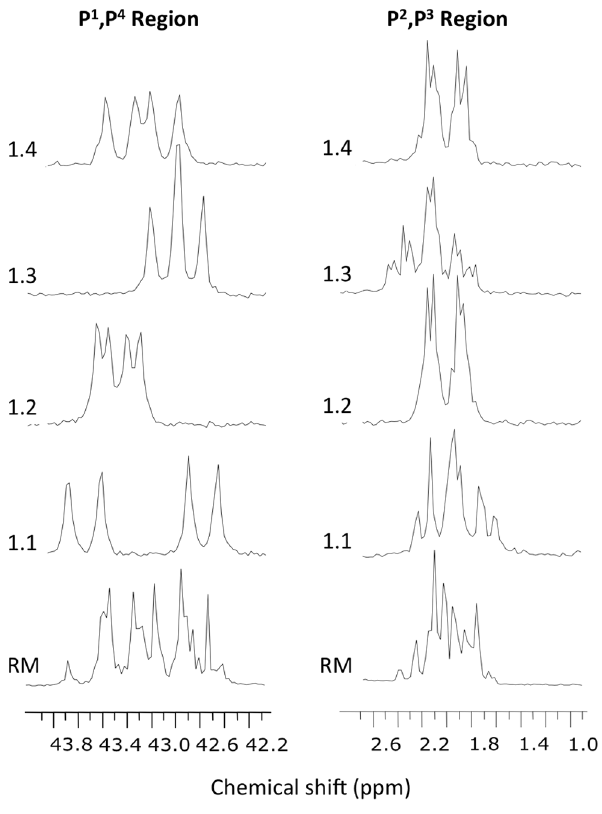
Figure 3. 31 P NMR Spectra ( 1 H decoupled) of the diastereomers of compound 1 and their racemic mixture. In the left panel are the P 1 ,P 4 regions, and in the right panel are the P 2 ,P 3 regions of the spectra. The traces are, from bottom to top: racemic mixture (RM), diastereomer 1.1 , 1.2 , 1.3 , and 1.4 .